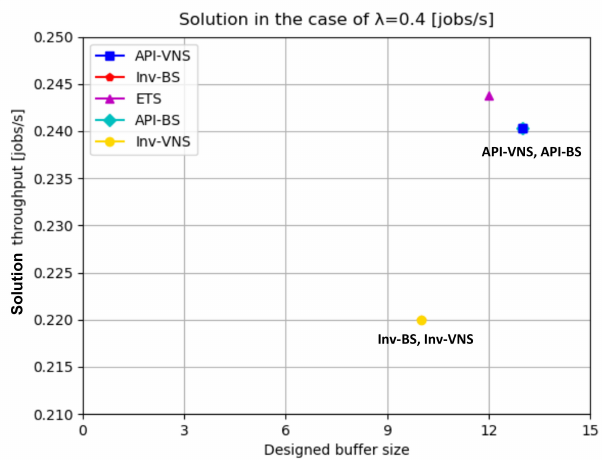
Figure 10. Computation time vs. throughput curves for the five methods in the case of λ = 0.6 in experiment 1.